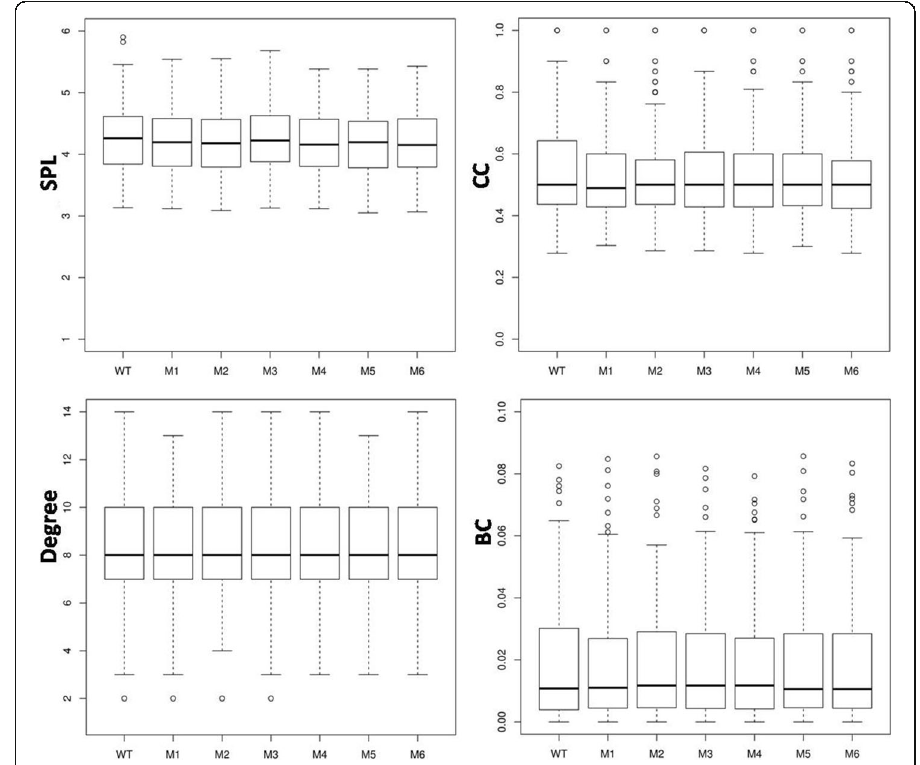
Fig. 5 The box plots of network parameters (SPL, CC, Degree and BC) for the seven PCNs (WT and